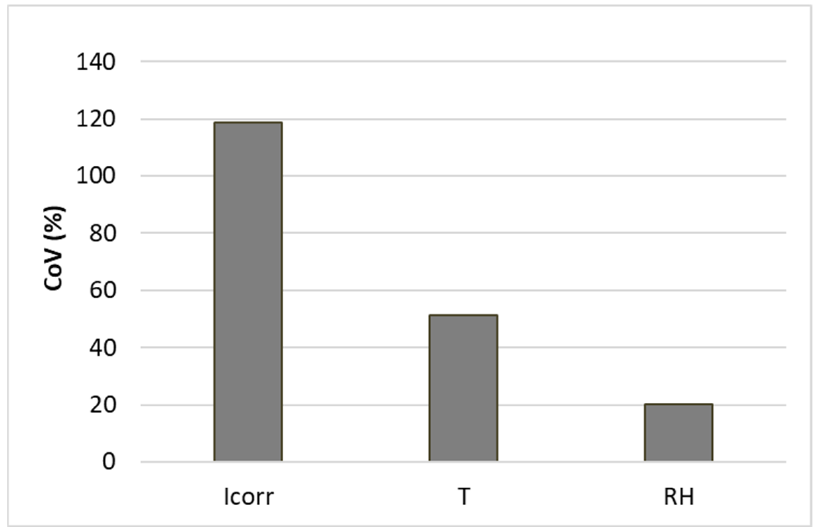
Figure 9. Coefficient of variation of the parameters shown in Figure 2 during the period delimited in that figure. that